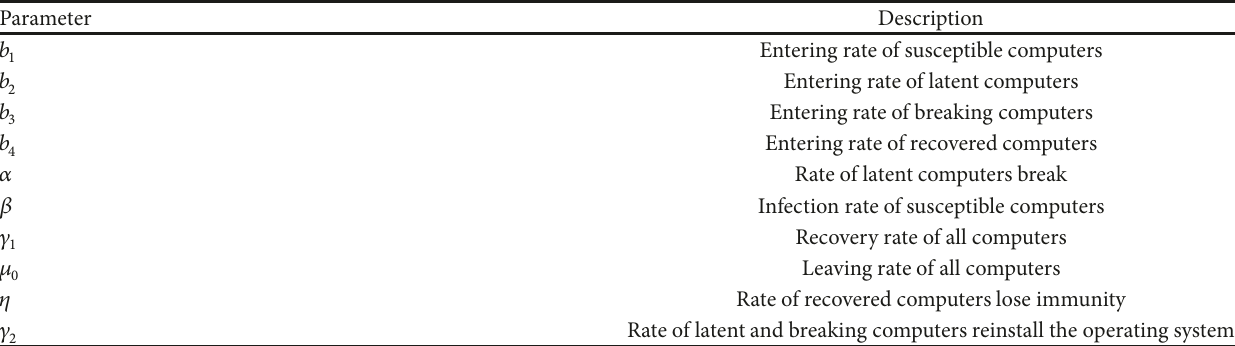
Table 1: Parameters and their meanings in this